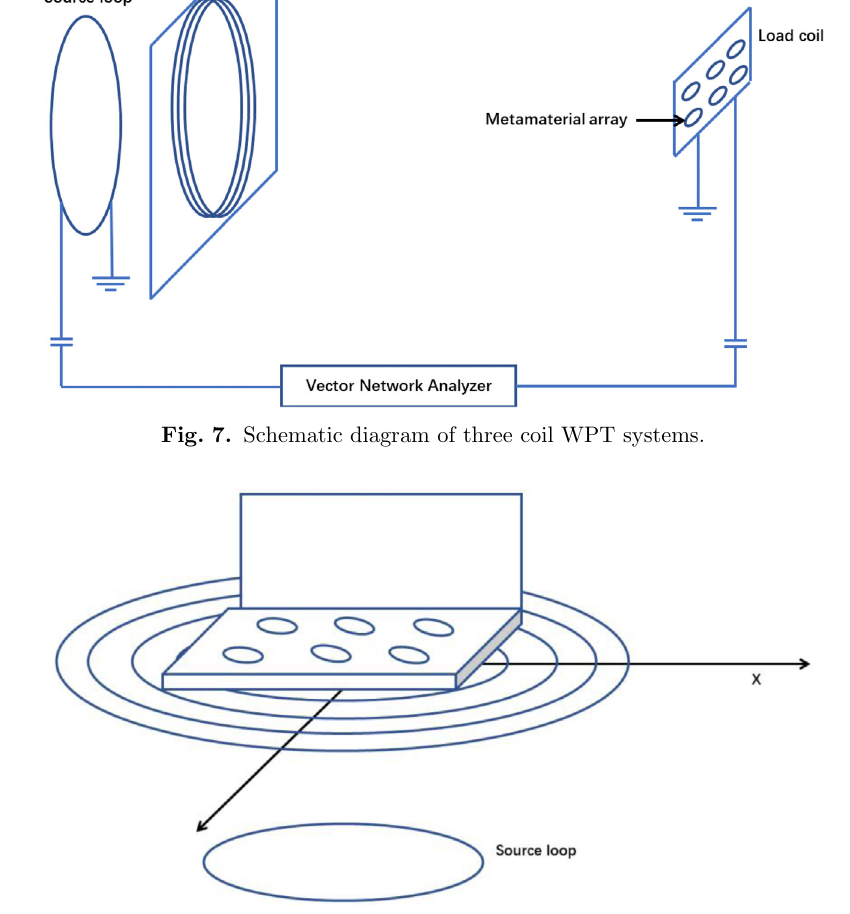
Fig. 8. WPT system position shift experiment with vertical